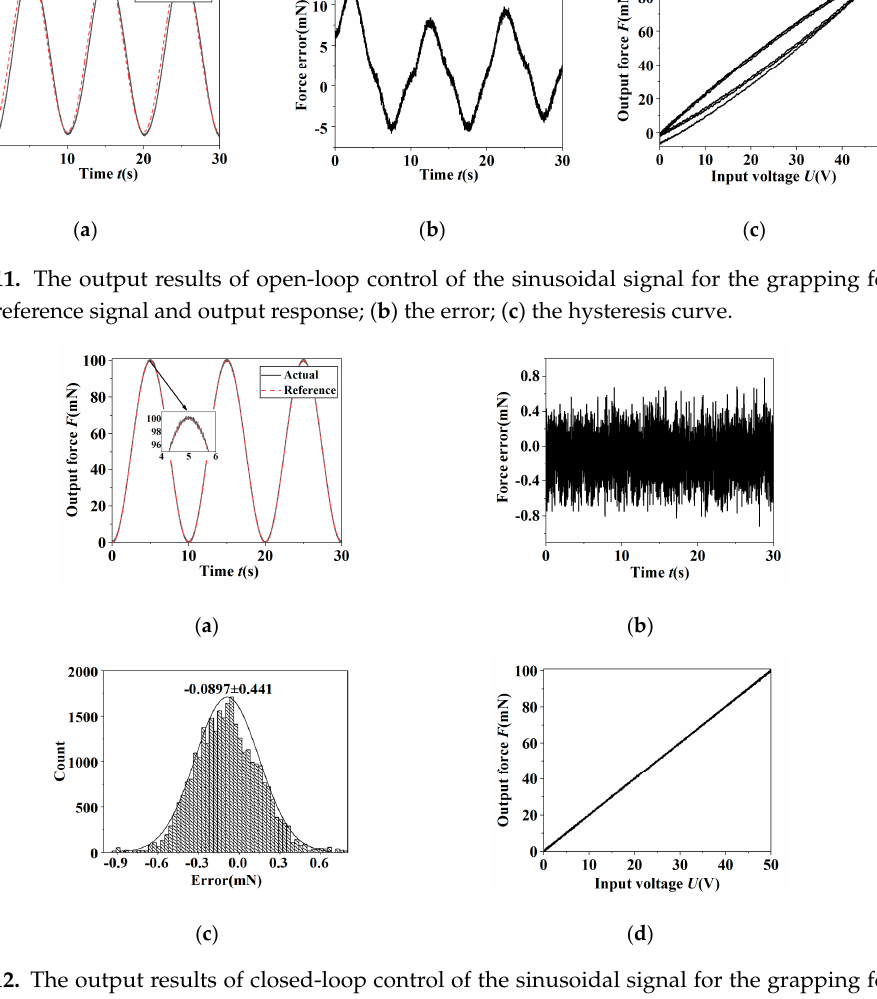
Figure 12. The output results of closed ‐ loop control of the sinusoidal signal for the grapping force. ( a ) The reference signal and output response; ( b ) the error; ( c ) error histogram; ( d ) the hysteresis curve.